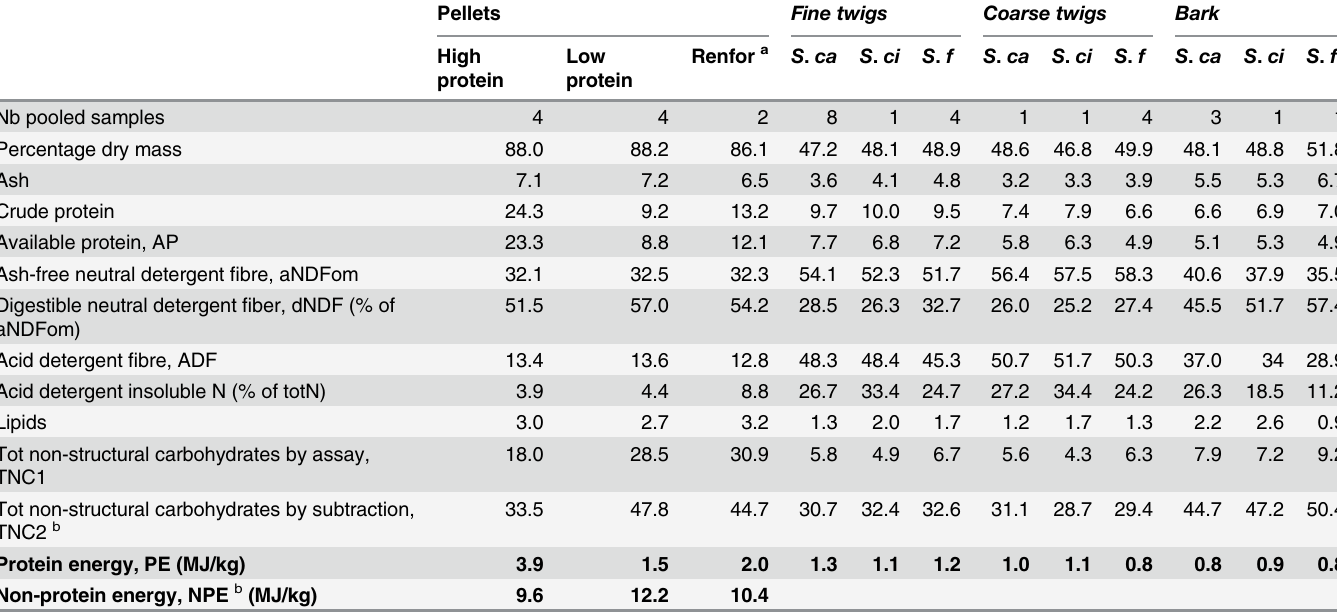
Table 2. Nutritional composition of pellet types and browse items from three Salix species eaten by captive moose at Sk å ne Zoo during the